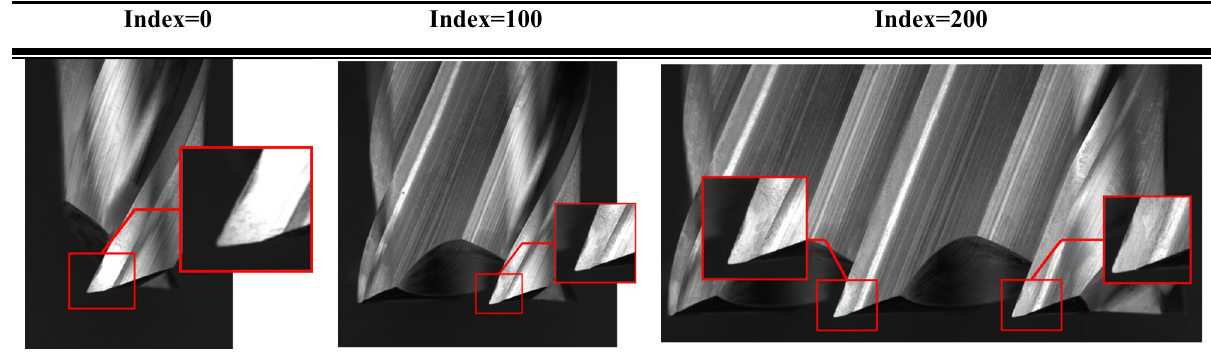
Table 1. The process of stitching several images into panorama image, where the red box indicates the